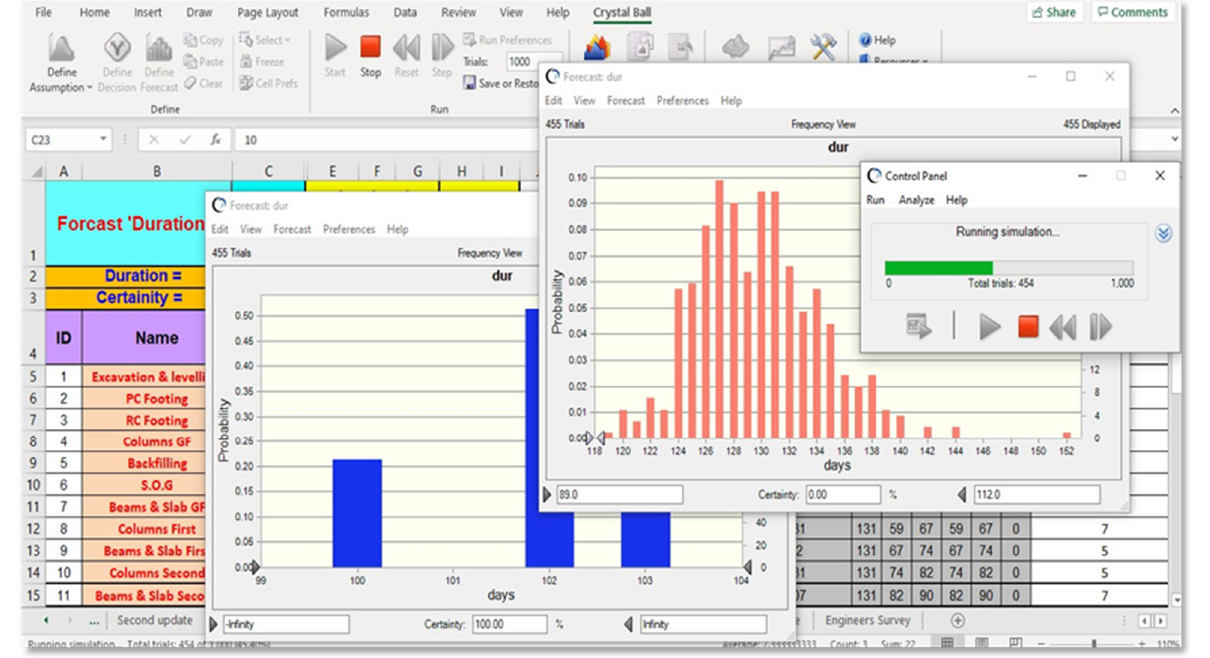
Figure 10. Simulation for activities durations using Crystal Ball software. Table 1. Activities listed in the case study with the predecessors and successors of each